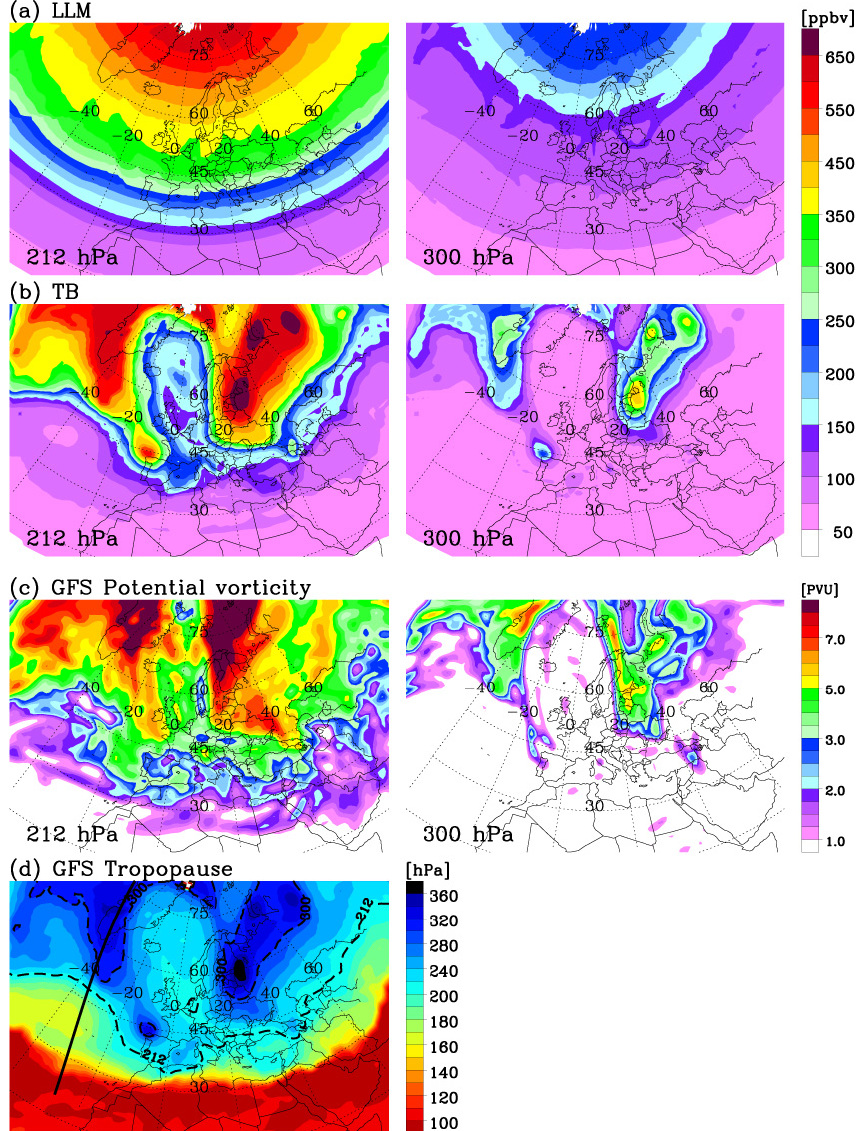
Fig. 4. Horizontal distributions of climatological mean ozone from LLM (a) and TB (b) climatologies at 212 and 300hPa over Europe on 30 April 2007. The associated potential vorticities (c) and tropopause heights (d) from GFS data are also presented. The solid black line in Fig. 4d indicates the location of the orbit of retrievals examined in Fig.